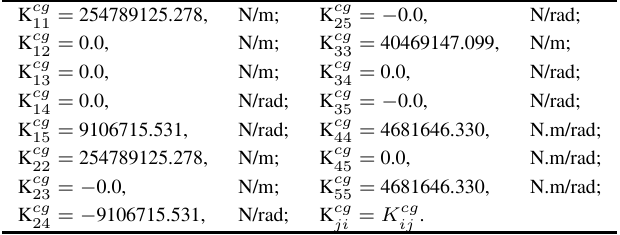
Table 7 Stiffness matrix coef fi cients of the grinding spindle-bearings assembly for